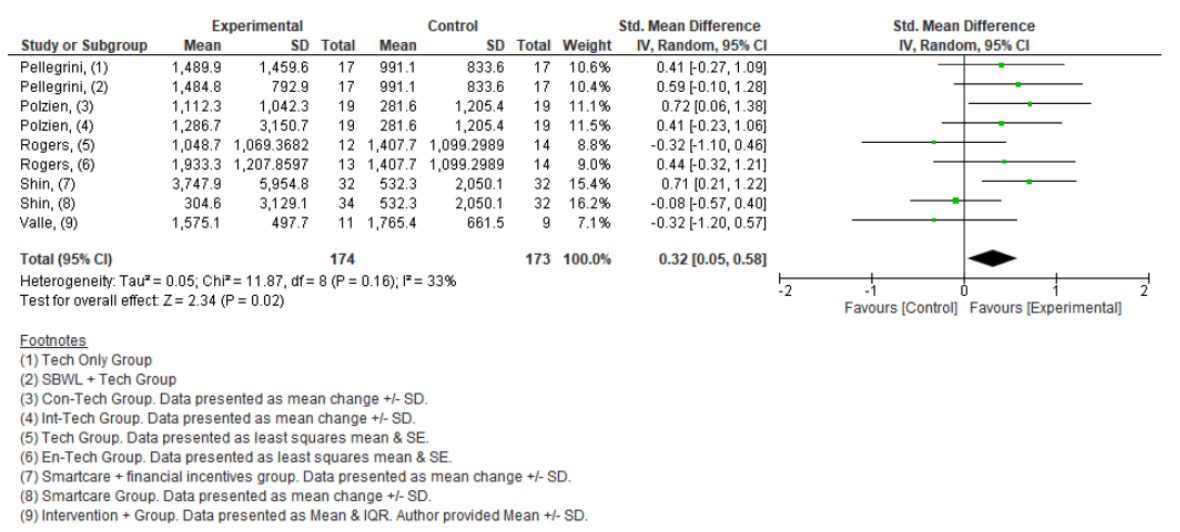
Figure 5. Forest plot of standardized mean difference of energy expenditure in studies comparing an intervention that included a consumer-based wearable activity tracker with a control group that did not utilize a consumer-based wearable activity tracker. Green square indicates the standardized mean difference for each individual study. Black square indicates the overall standardized mean difference for all